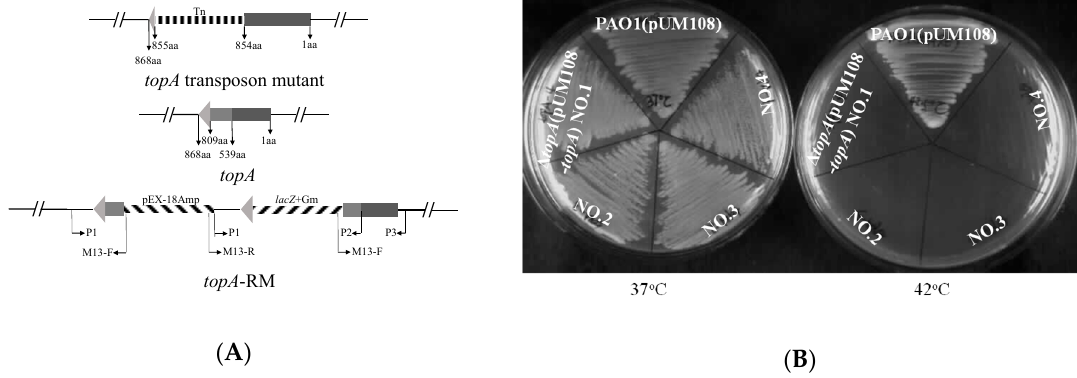
Figure 1. Schematic depiction of the genomic organization of topA in topA -RM and topA transposon mutant, and growth test showing the essentiality of TopA. ( A ) Schematic presentation of the genetic structure of topA in topA -RM and topA transposon mutant. Top: topA was separated by the transposon element (Tn). Middle: intact topA gene on the chromosome. The amino acid residues at which split-up occurred during the recombination event are indicated. Bottom: the three topA fragments in topA -RM are shown. P1, P2, P3, are PCR primers with their binding sites shown. M13-F and M13-R are universal primers that bind to the pEX18Amp plasmid. These primers were used to determine the genetic structure of top -RM (Table S1, Figure S1). ( B ) Growth of the topA chromosomal deletion mutant that carried a copy of topA on the temperature-sensitive plasmid pUM108 at 37 ◦ C, whereas there was no growth at 42 ◦ C. PAO containing pUM108 was able to grow at both temperatures. Four different isolates (No.1 to 4) of the topA conditional mutant are shown.